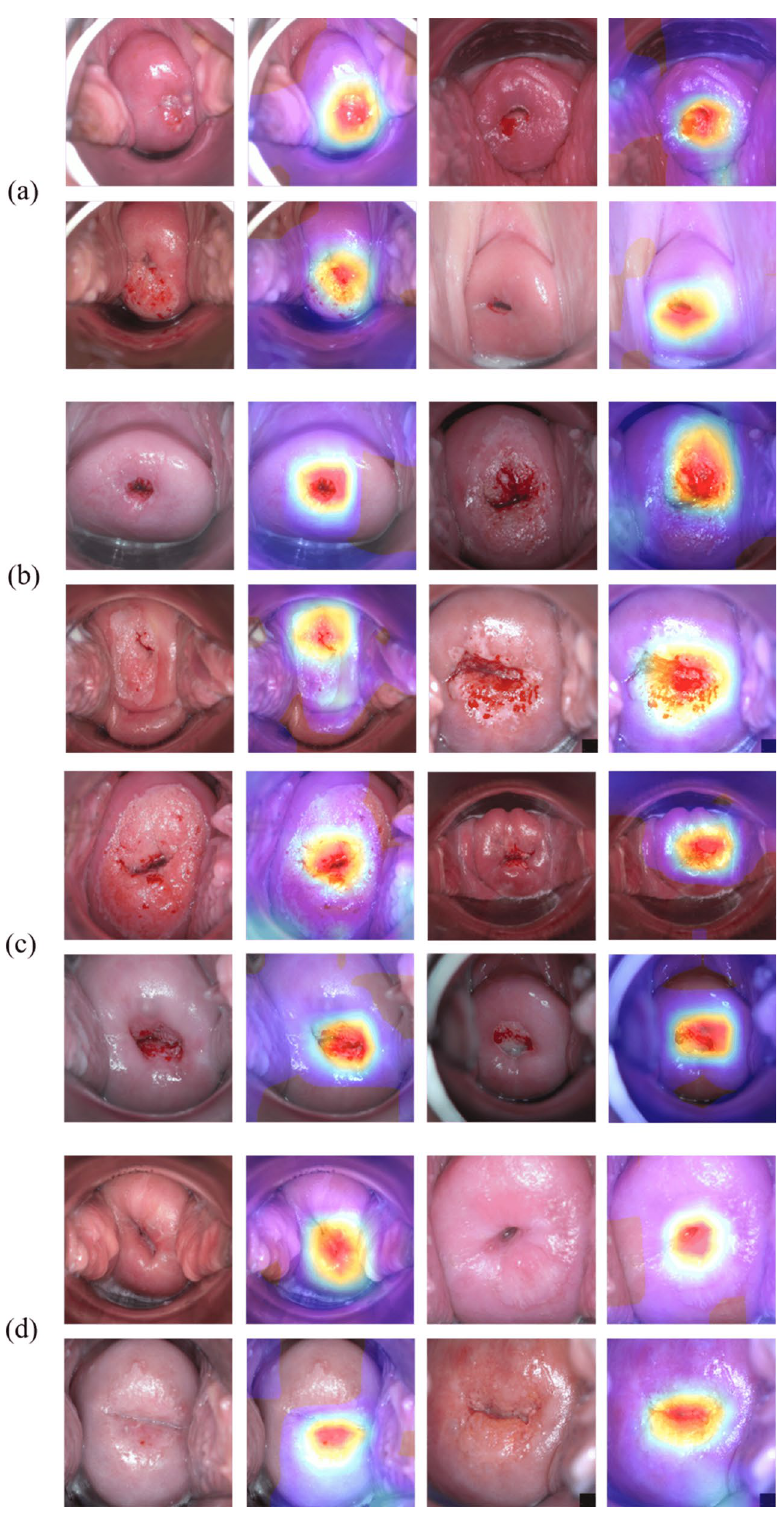
Figure 6. Examples of CAM images of test sets. ( a ) True Negative (ground truth: negative, predict: negative) ( b ) True Positive (ground truth: positive, predict: positive) ( c ) False Positive (ground truth: negative, predict: positive) ( d ) False Negative (ground truth: positive, predict: